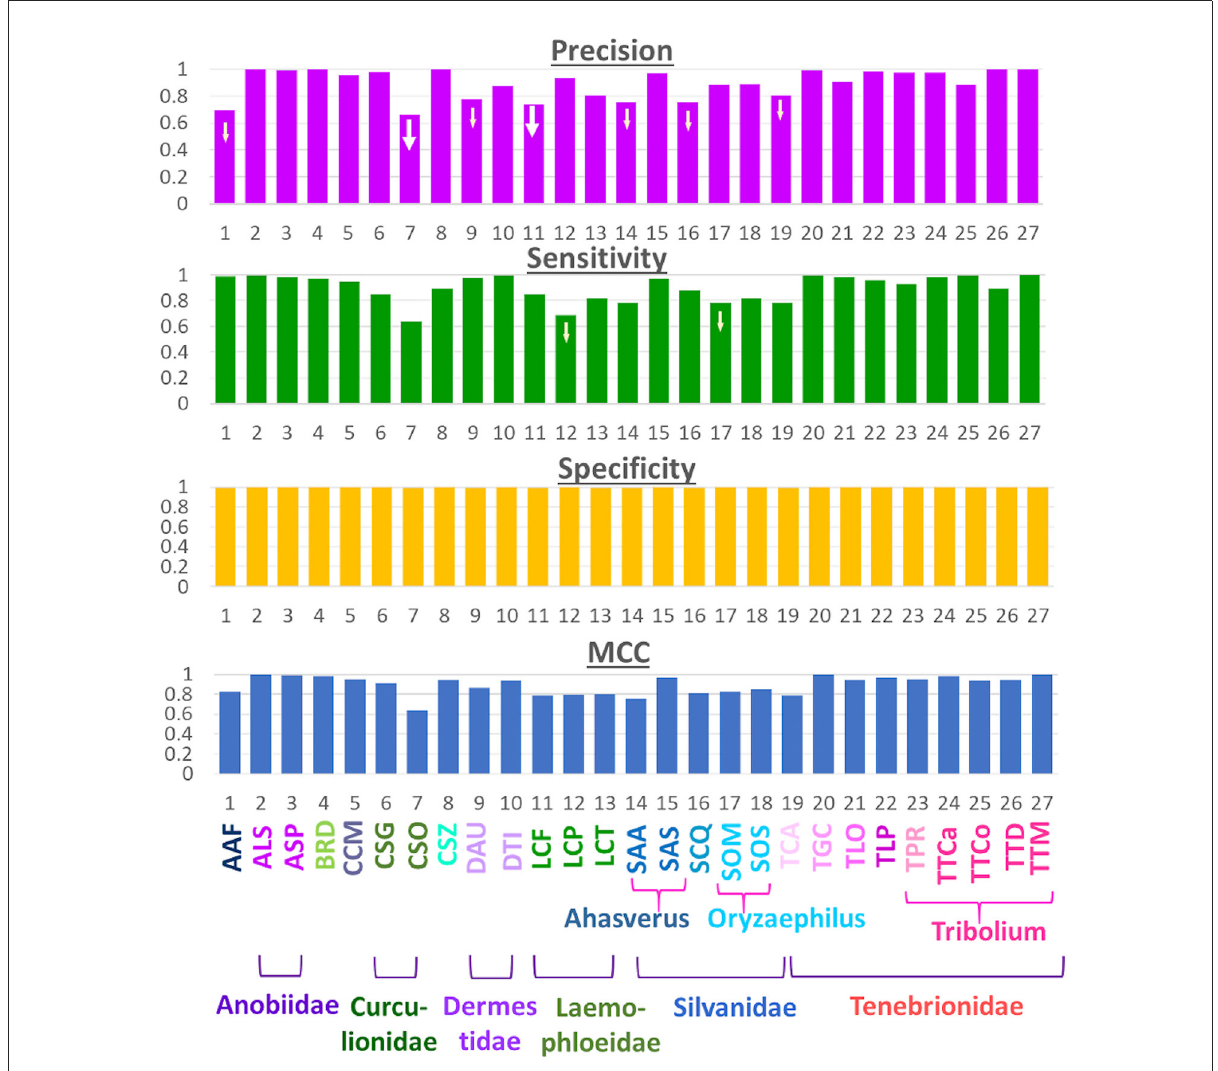
FIGURE4 Performance metrics for the 27-class